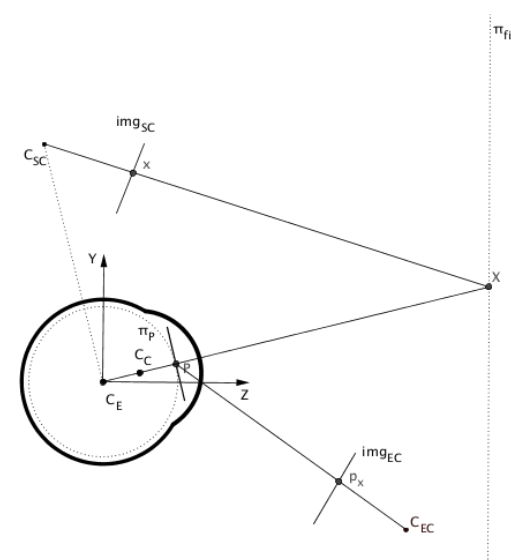
Figure 1 . Sagittal view of a HMGT